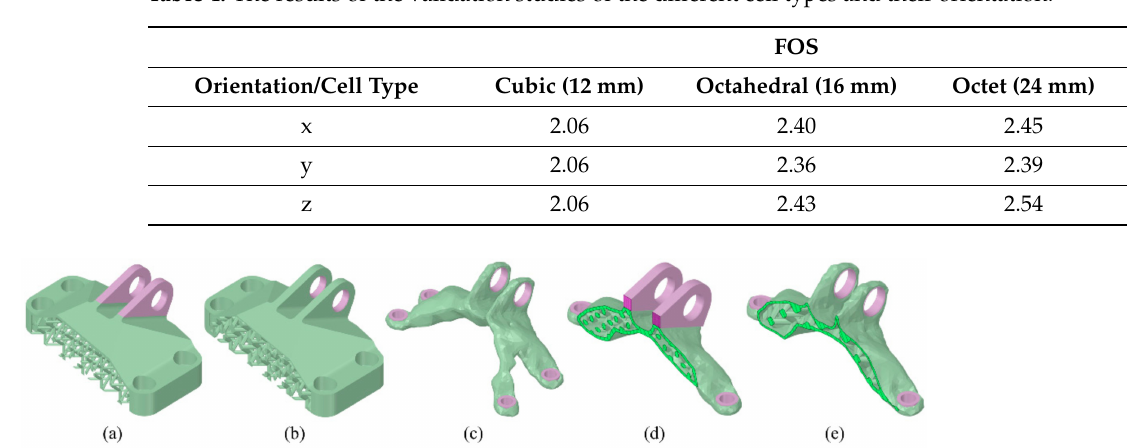
Figure 10. Three different orientations of the octet cell: ( a ) x orientation, ( b ) y orientation, and ( c ) z orientation. Table 4. The results of the validation studies of the different cell types and their orientation.